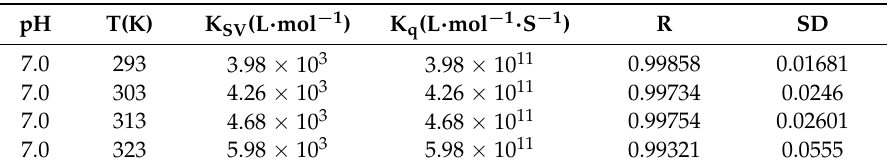
Figure 7. Stern–Volmer plots for the system of FCNs in the presence of metronidazole under temperatures of 293, 303, 313, and 323 K, respectively. F 0 and Fare the fluorescence intensity of FCNs in the absence and presence of metronidazole, respectively. Conditions: FCNs, 500 μL; PBS, 0.2 M, pH = 7.0. Table 1. Stern–Volmer quenching constants for the interaction of C-Dots and metronidazole at different temperatures.